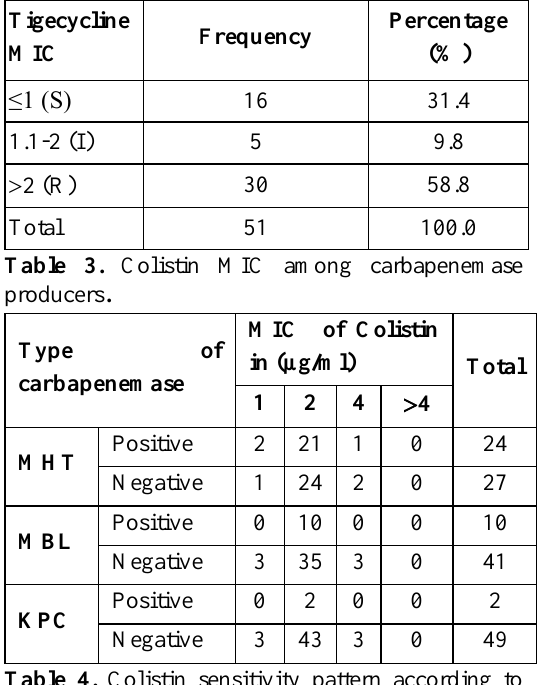
Table 10. Comparison of disc diffusion and MIC for tigecycline.